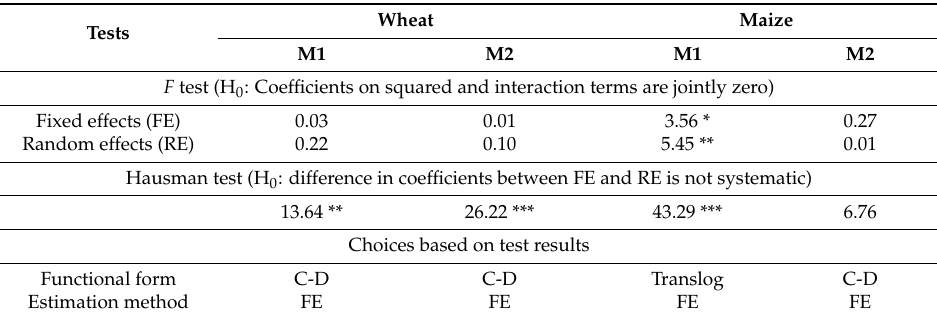
Table 5. Tests to determine crop production function specifications and estimation